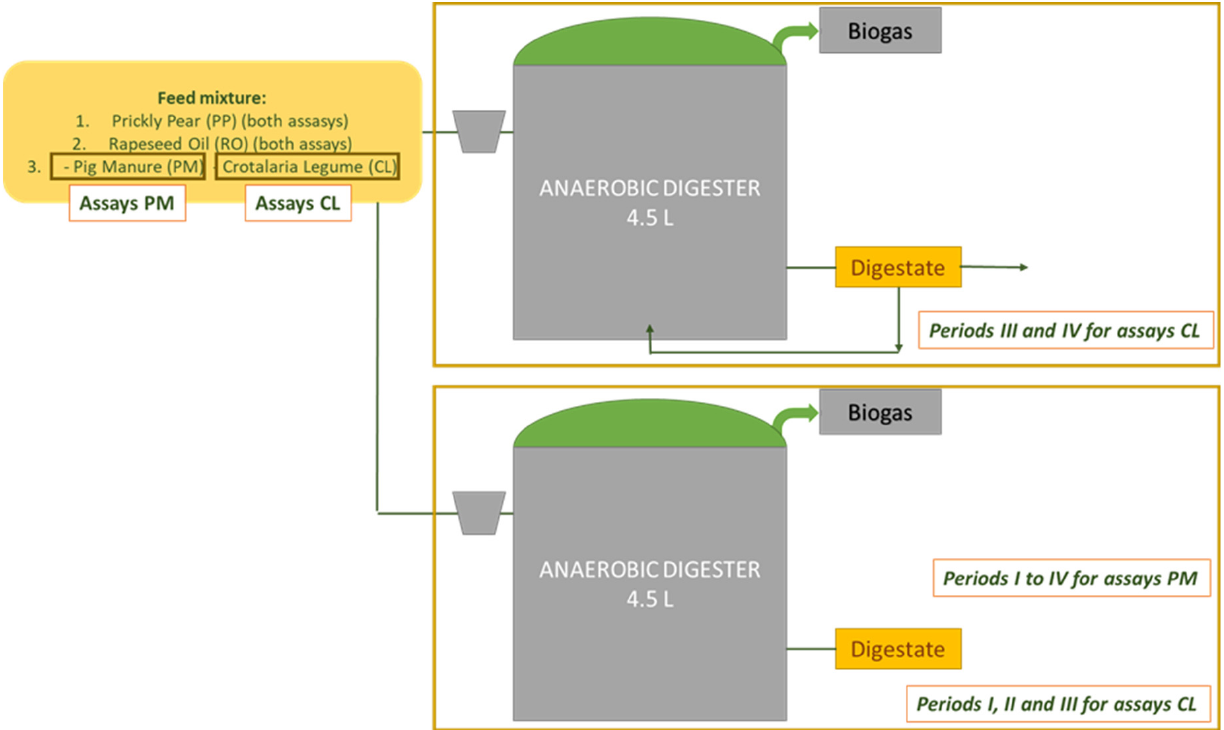
Figure 1. Experimental feeding setup.